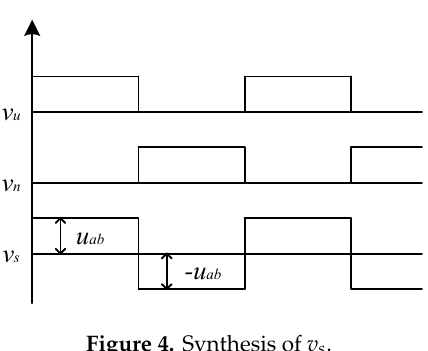
Figure 4. Synthesis of v s . Table 1. Twelve operating states of the matrix converter.